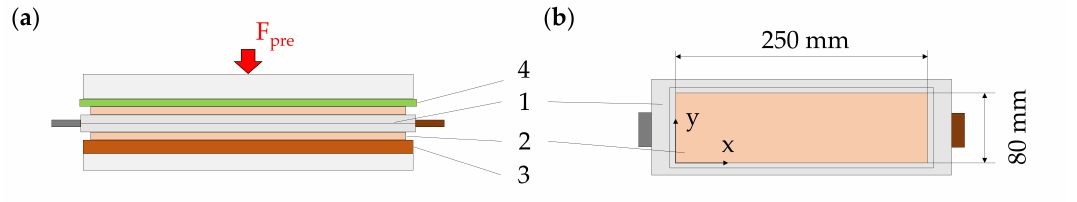
Figure 1. ( a ) Sketch of the test setup including the pouch cell (1), compression pads (2), phenolic paper (3) and pressure mapping sensor (4). ( b ) Area covered by the compression